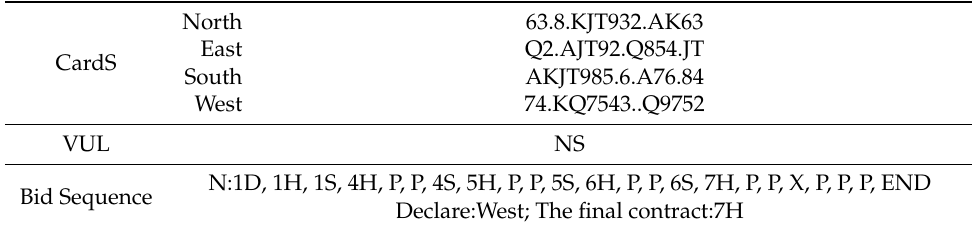
Table 2. Test Case . The actual situation is that the North and South players have nine cards with ♠ , nine cards with ♦ and the East and West have 11 cards with ♥ . The hands of both sides are very obvious. The North and South players prefer the contract called ♠ or ♦ . It is biased towards the contract called ♥ . After fierce bidding, the West player is the declarer, and the contract is 7H. North 63.8.KJT932.AK63 East Q2.AJT92.Q854.JT CardS South AKJT985.6.A76.84 West 74.KQ7543..Q9752 VUL NS Bid Sequence